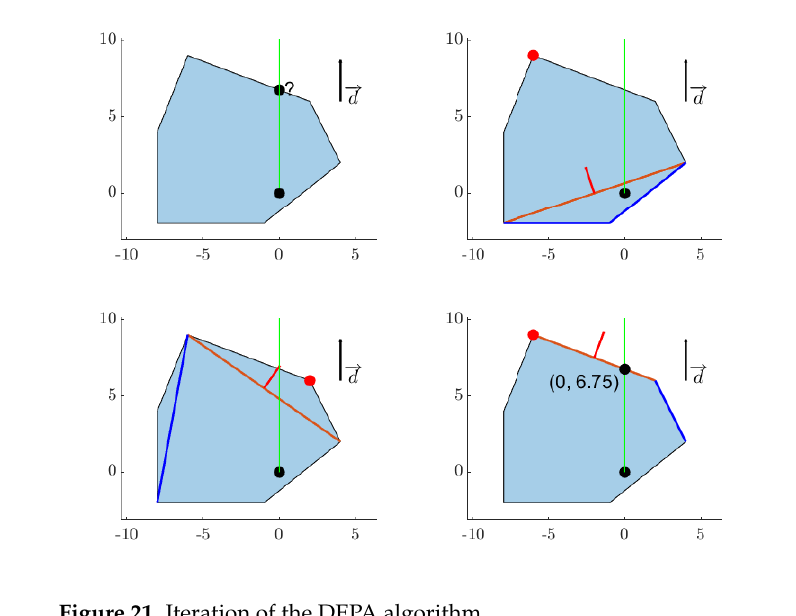
Figure 21. Iteration of the DEPA algorithm.